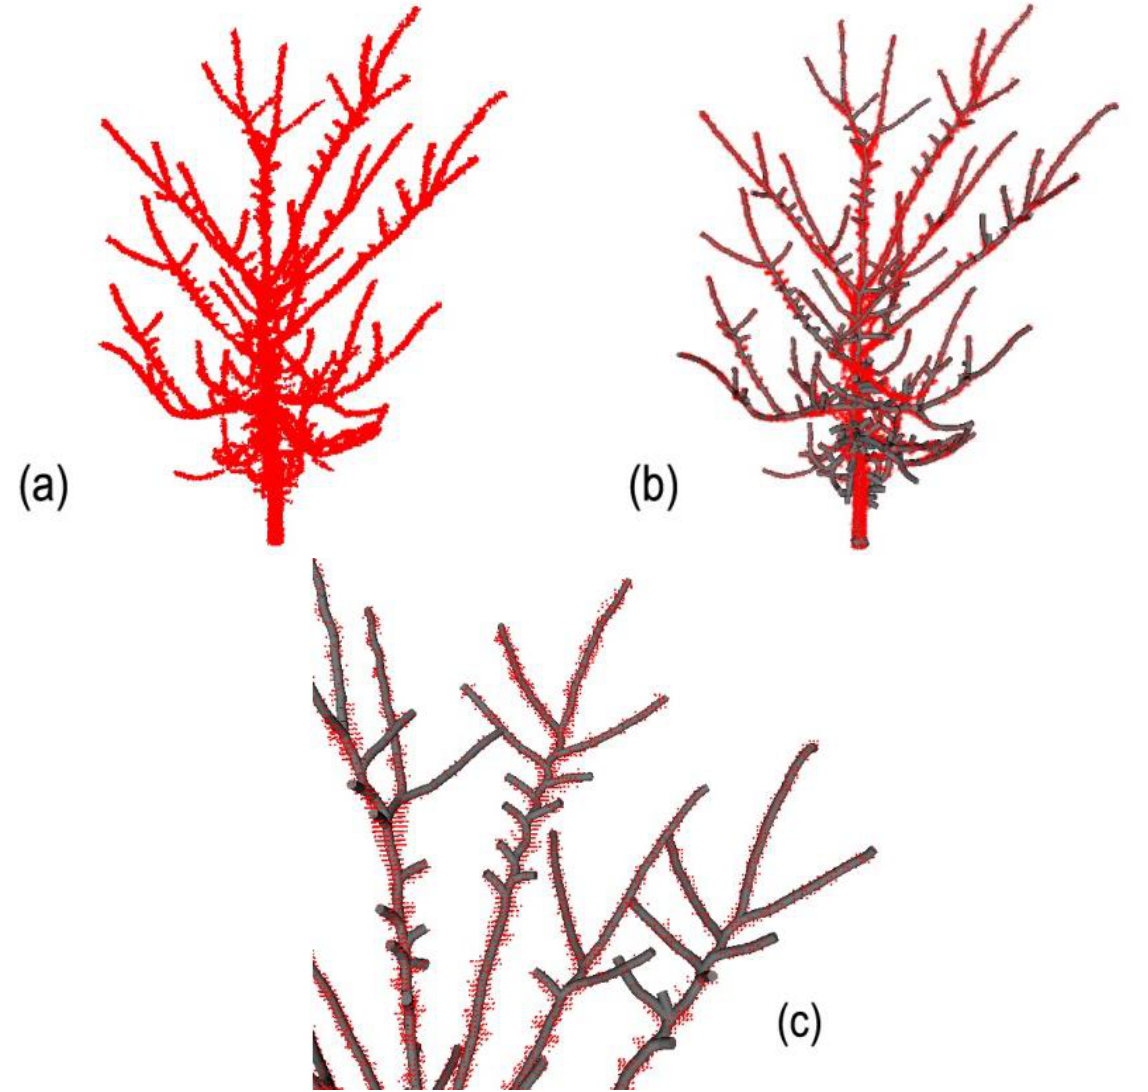
Figure 7. Automatic elm reconstruction. ( a ) Original point cloud from TLS (120,000 points); ( b ) Automated reconstruction using the following parameter combination: r = 0.025; d = 0.025; w = 3; ( c ) Close-up of the elm canopy showing the detection of the long axis but omission of some short second-order